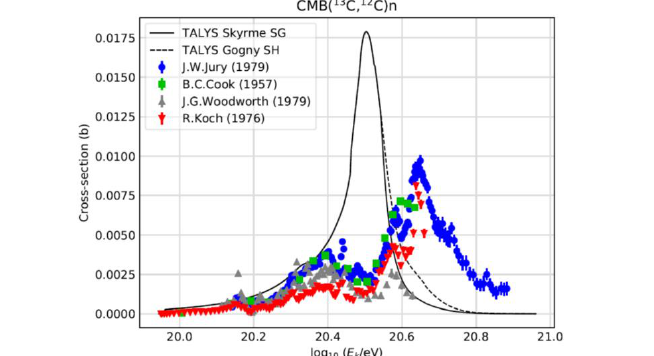
Fig. 3. Comparison of the experimental data for the cross-section of the 13 C(γ,n) reaction and theoretical calculations within the TALYS computer code using Skyrme and Gogny parametrizations of the level